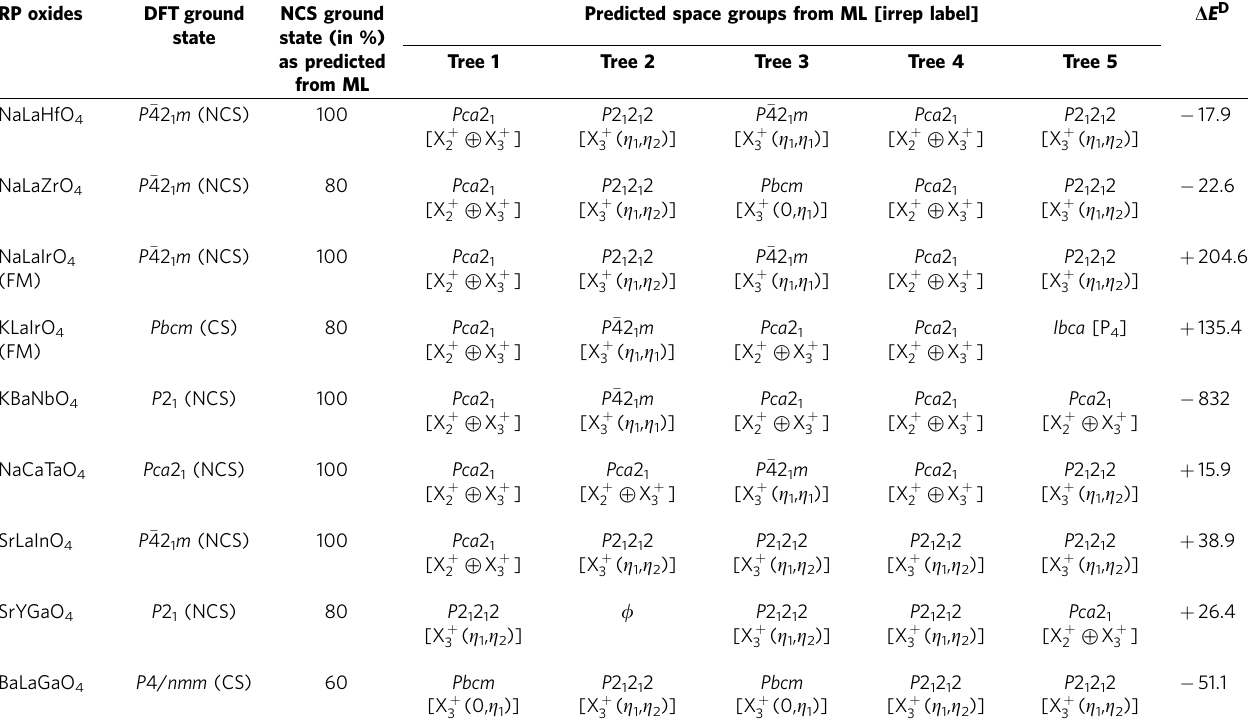
Table 7 | DFT aided validation for nine randomly selected RP oxides that were predicted to have an NCS ground state structure from ML.